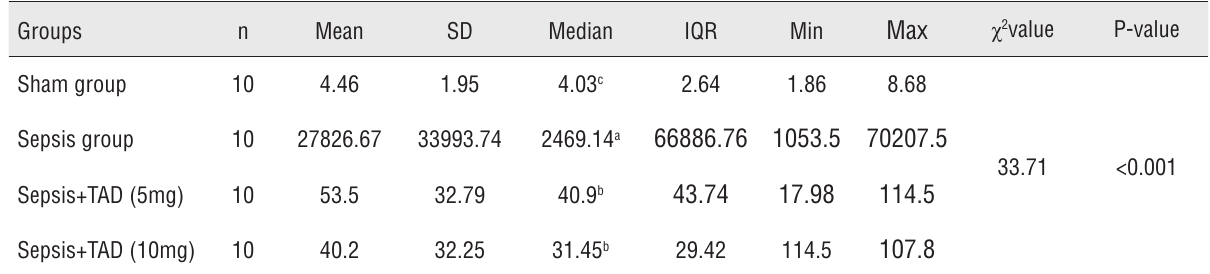
Table 3 - variations in IL-6 levels between the groups.